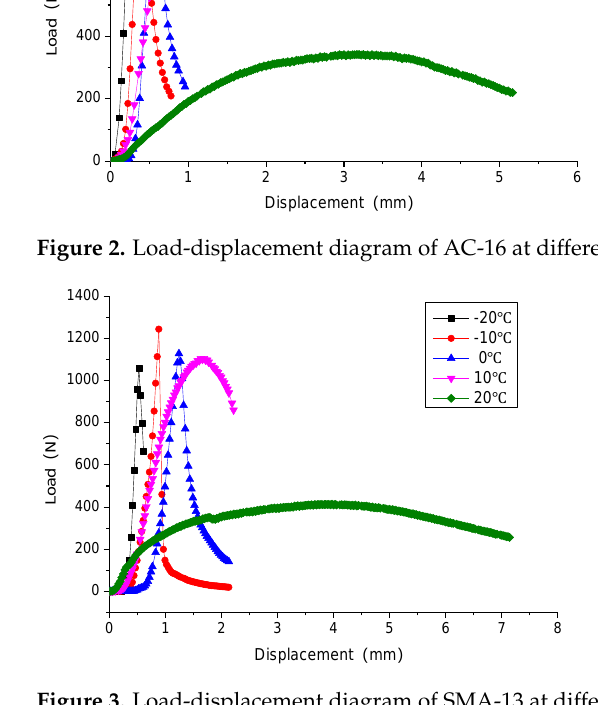
Figure 3. Load-displacement diagram of SMA-13 at different temperatures.